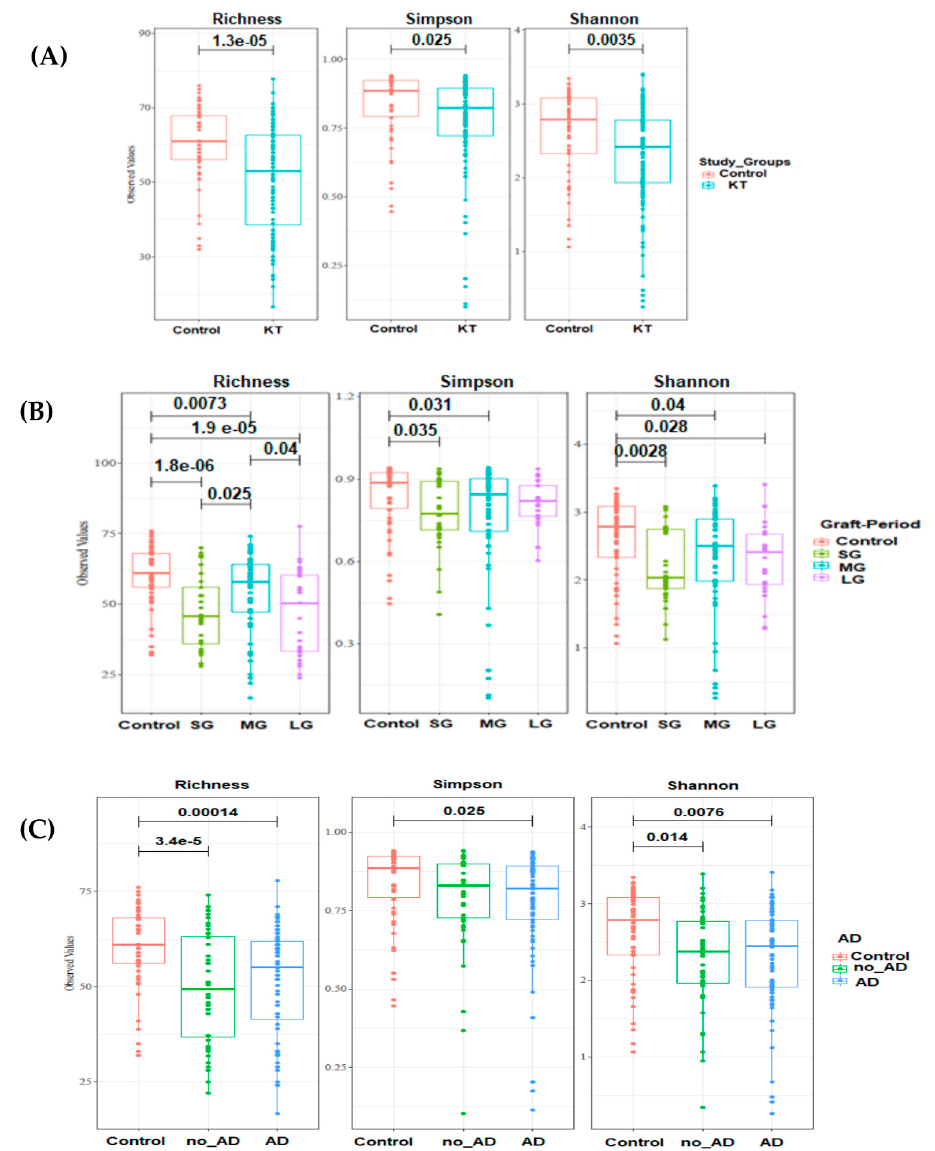
Figure 1. Boxplots of OTU’s richness, Simpson and Shannon diversity indexes distinguishing between kidney transplant (KT group) and control group. Statistical analysis was performed with Wilcoxon rank-sum test. ( A ) Alpha diversity indexes within control (n = 18) and kidney groups (n = 40). ( B ) Alpha diversity analysis among kidney transplant recipients over time: short period group: <1 year (SG; n = 11), medium-length period group: 1–10 years (MG; n = 20), and long period group: over 20 years (LG; n = 9). ( C ) Richness and diversity indexes within patients with and with no associated diseases (AD) groups (n = 24 and n = 16 respectively). Study groups are statistically different ( p -value < 0.05).